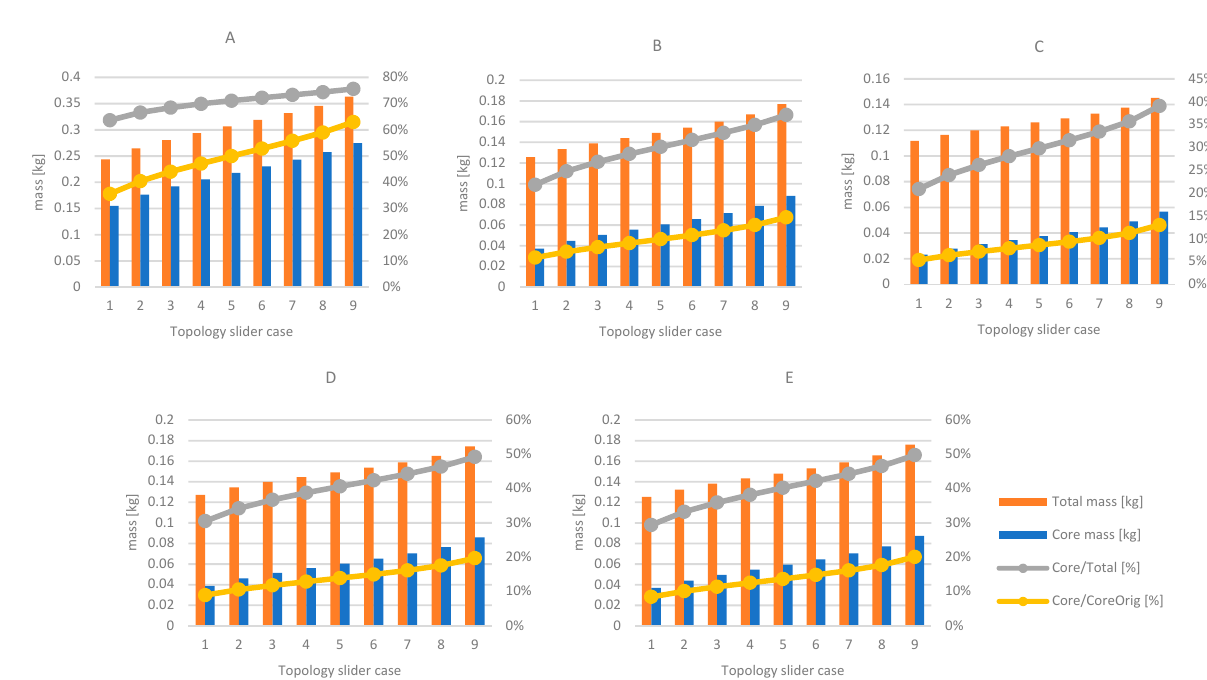
Figure A5. Optimization target neighborhoods. Letters ( A – E ) corresponds to respective optimization run.